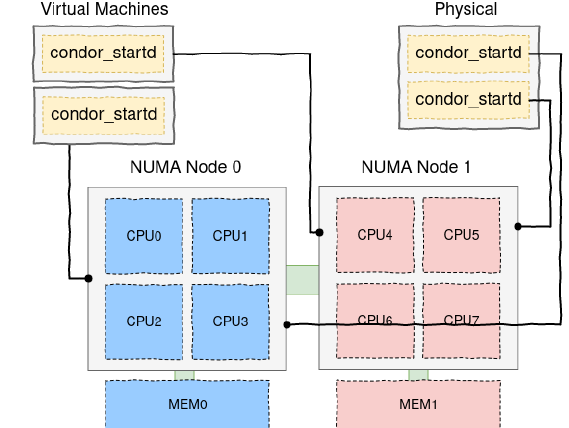
Figure 3. NUMA pinning is done at the virtualization layer on virtual nodes, and at the process daemon level on